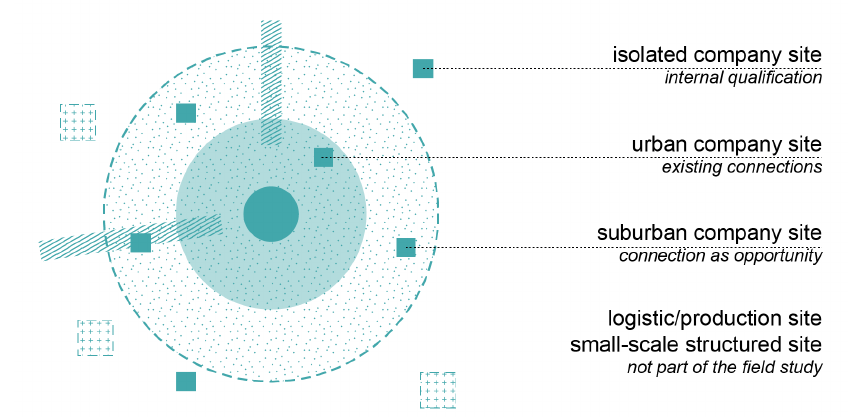
Figure 5. Company sites: From NoGo to Go. Source: Own drawing based on Roost et al. (2021, p. 37). new tenants to create synergies (partnerships and coop‐ eration with both academia and competing firms, or with companiesthatadd value or offera perfectcomplement).